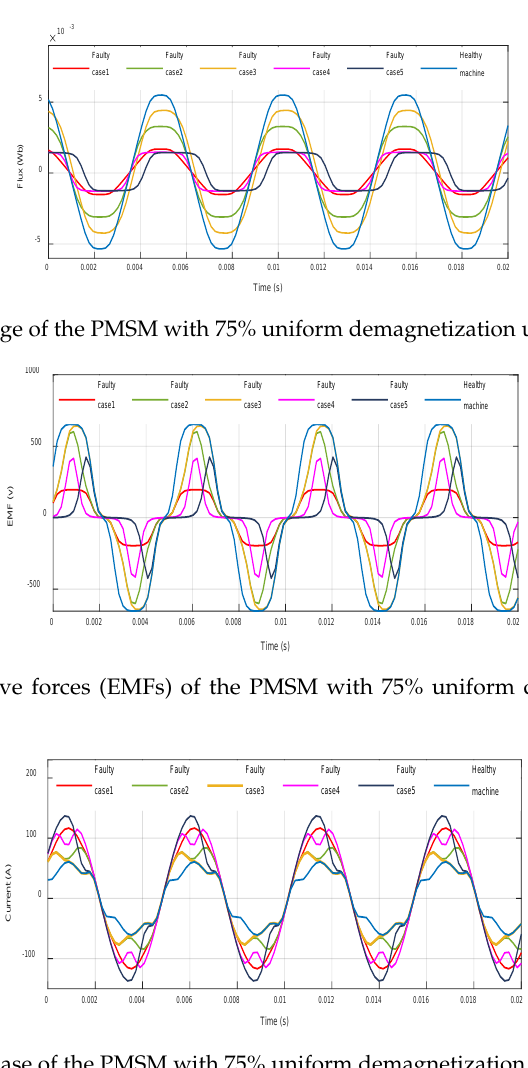
Figure 13. Current phase of the PMSM with 75% uniform demagnetization under different cases.